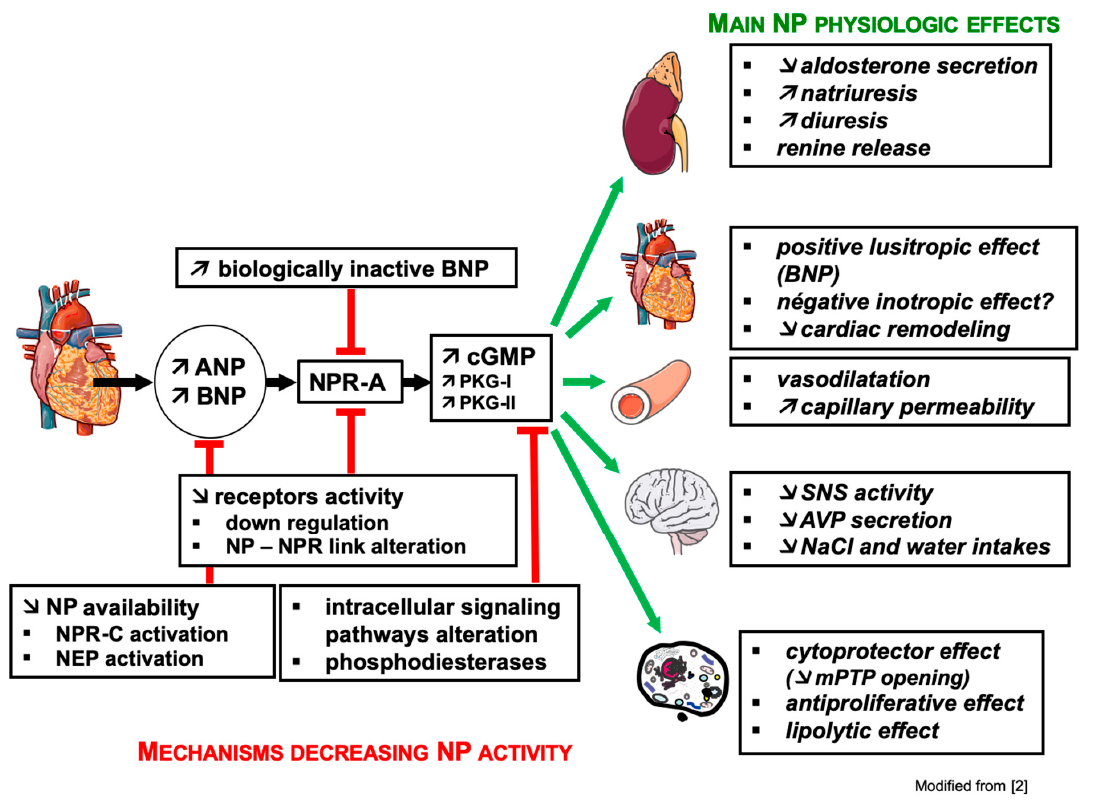
Figure 2. The main physiological effects of cardiac natriuretic peptides (NPs) and